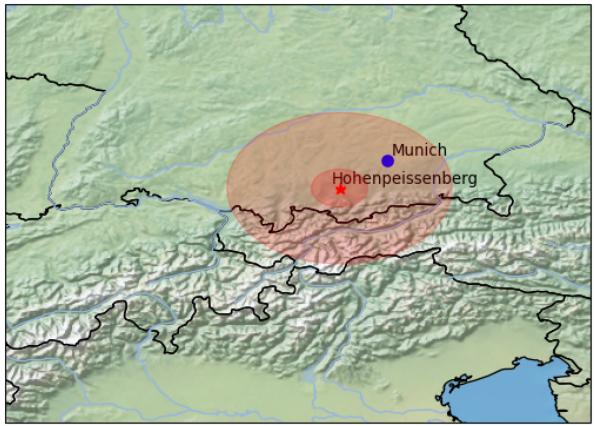
Figure 8. Southern Germany and the Alps, including the location of the Hohenpeißenberg sounding station and a circle of 25km to illustrate the size of the area sampled by the satellite. For compari- son, a second circle with 100km radius is shown. The larger circle includes both urban (Munich) and alpine regions. Due to the pro- jection the circles are slightly distorted. Image made using Natural Earth.